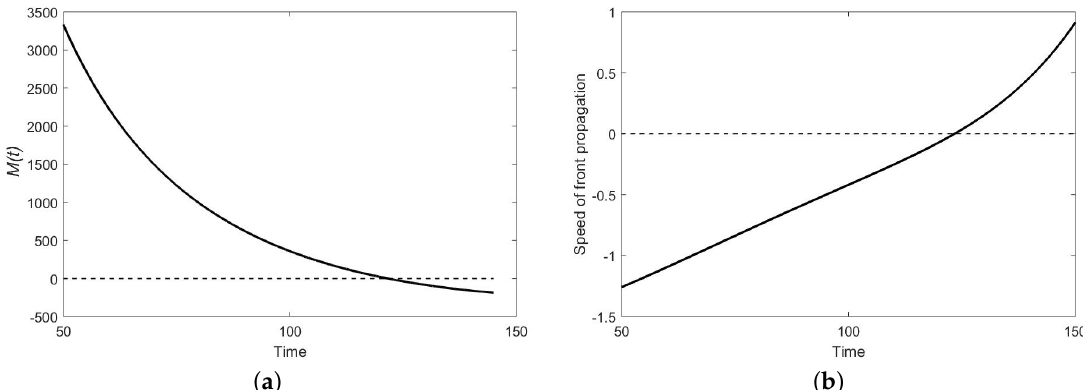
Figure 6. Dependence on time of ( a ) M and ( b ) the speed of the front calculated in the course of the travelling front propagation. The parameters are the same as in Figure 5a. It is readily seen that the moment ( t ≈ 123) when the front changes the direction of its propagation (invasion changes to retreat) coincides with the moment when M changes its